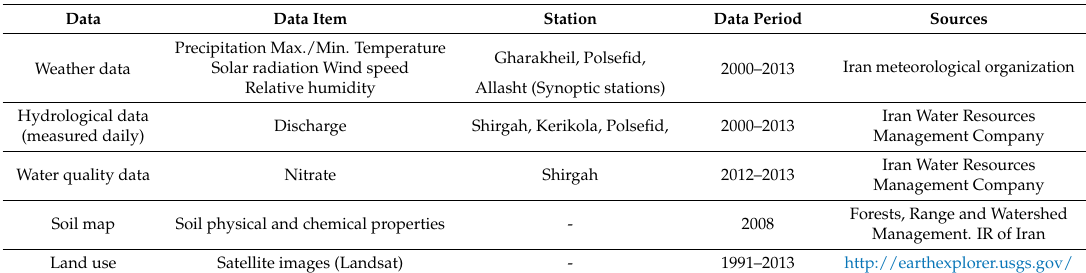
Table 1. Model inputs and data sources for the studied watershed.